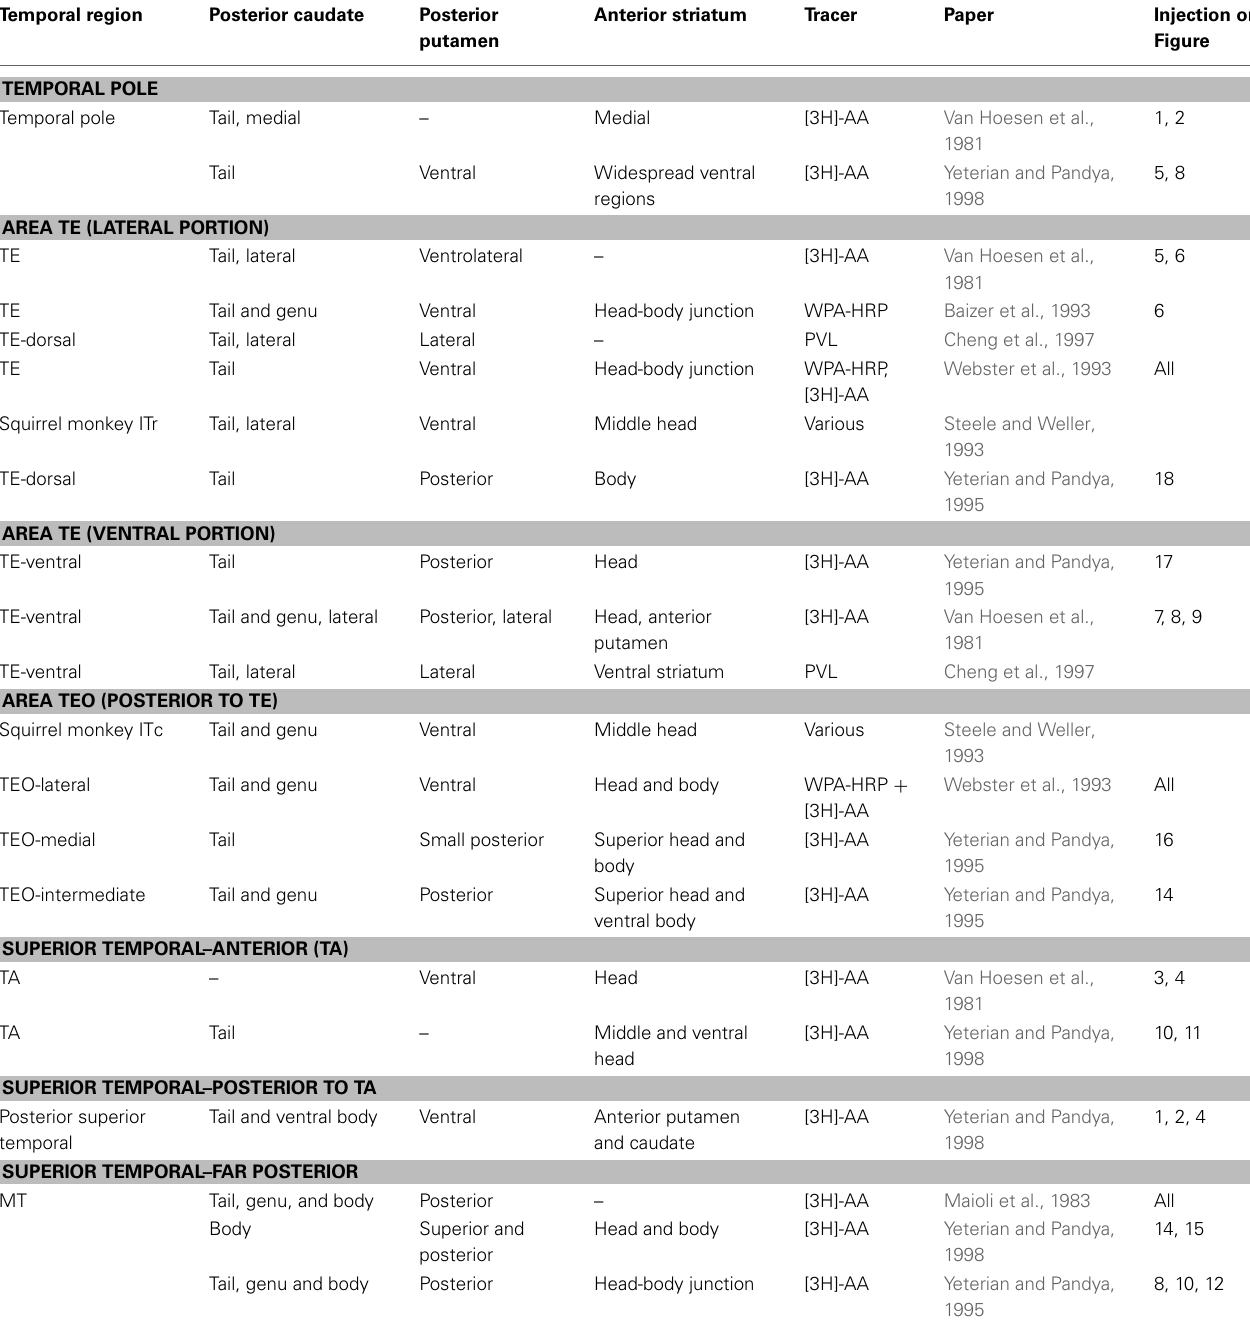
Table 1 | Tracer studies examining projections from extrastriate visual cortex to striatum in